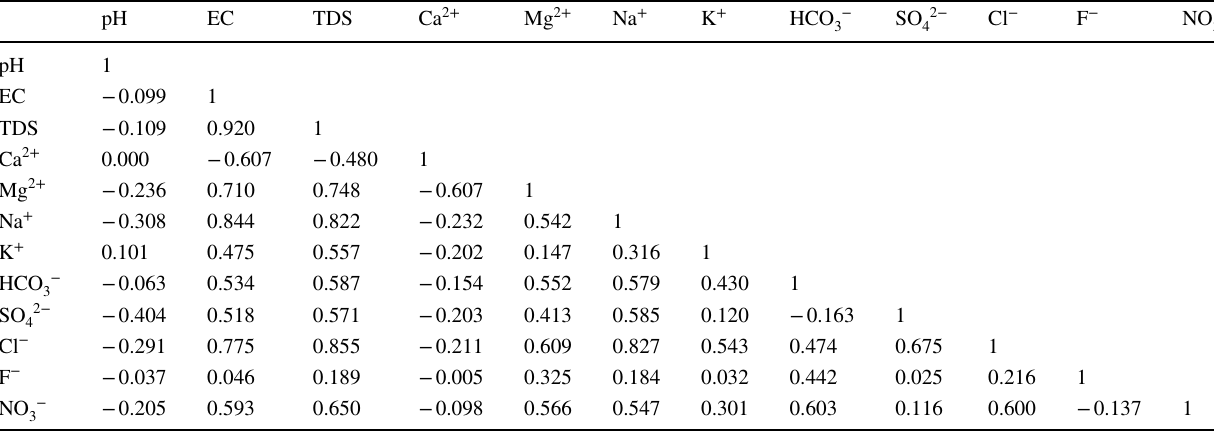
Table 3 Correlation matrix for the groundwater